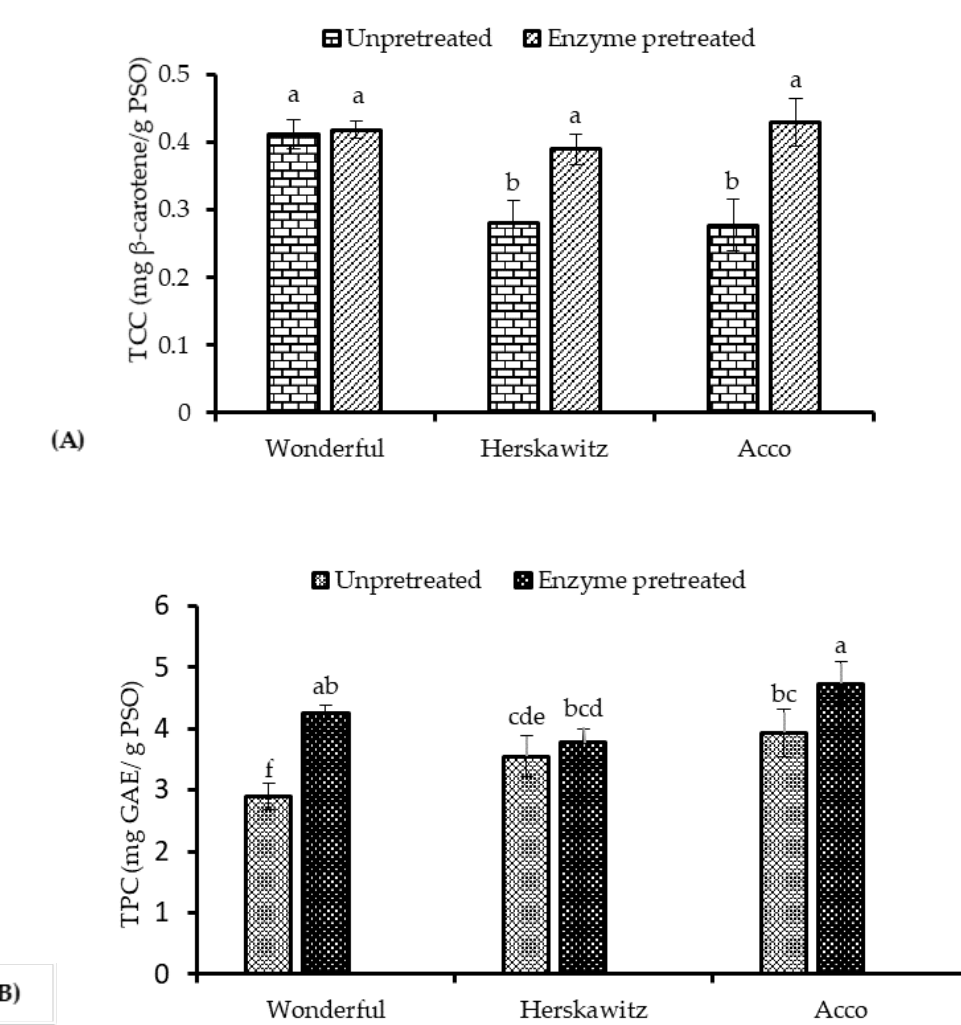
Figure 4. ( A ) Total carotenoid content (TCC) and ( B ) total phenolic compounds content (TPC) of un-pretreated and enzyme pretreated seeds (1.7%, 40 ◦ C, pH = 4.5 and 5 h) from three pomegranate cultivars. Within the same cultivar (un-pretreated and enzyme pretreated), columns followed by different letters are significantly different ( p < 0.05), according to Duncan’s multiple range test. Vertical bars indicate the standard deviation of the mean.